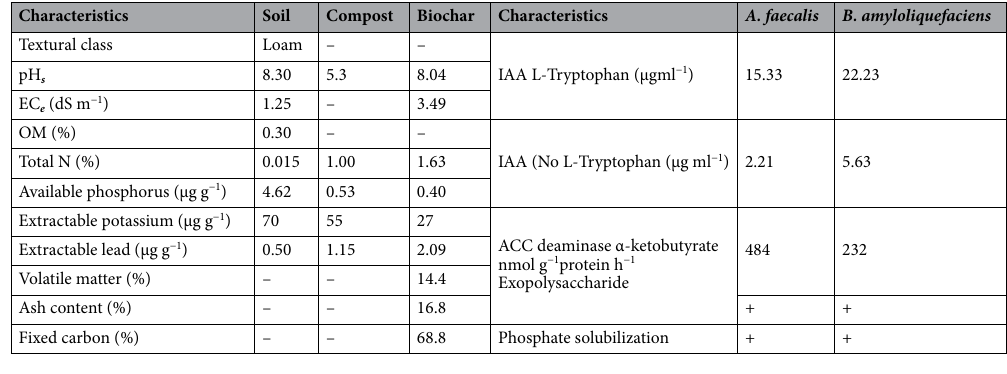
Table 1. Analyses of compost, soil and rhizobacteria (Pre-sowing) 55 .